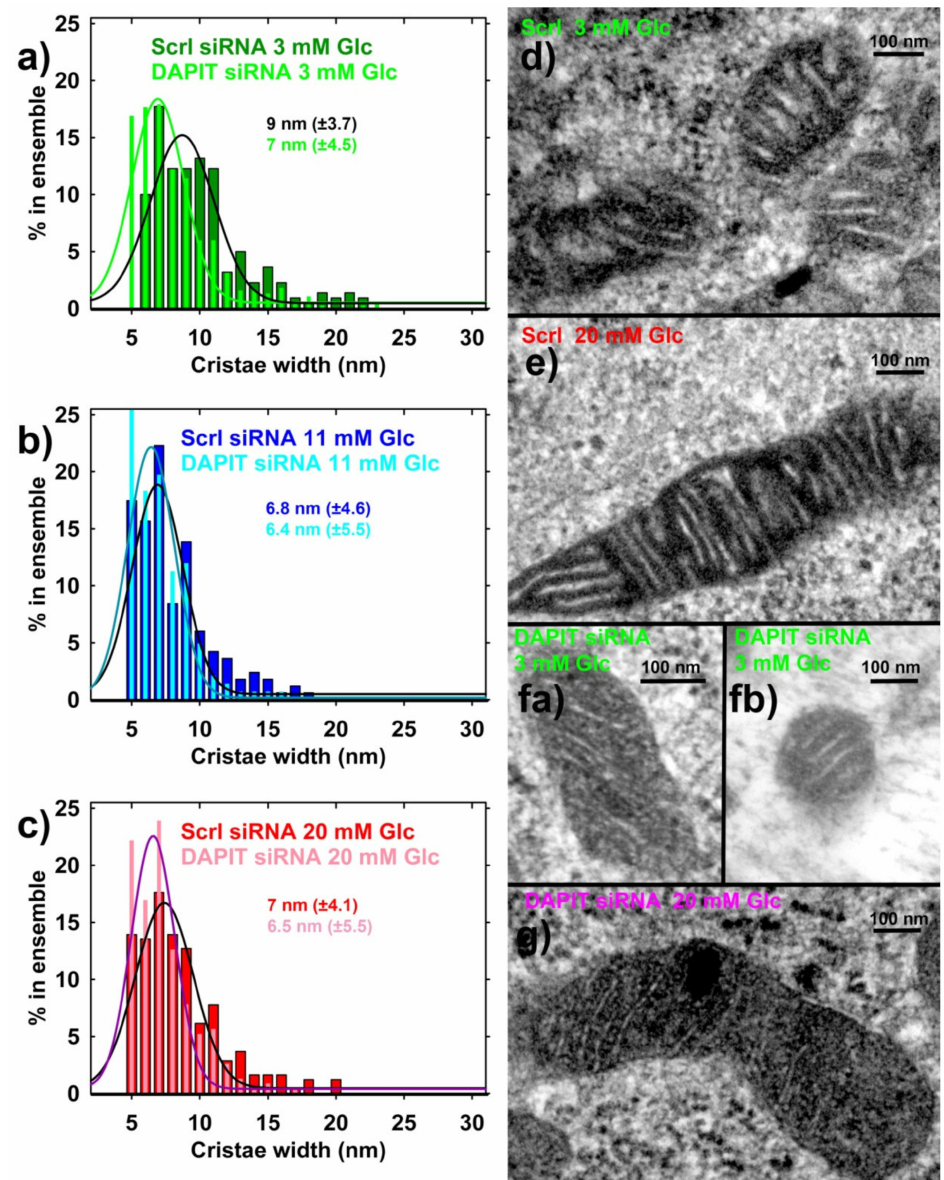
Figure 9. Mitochondrial cristae in DAPIT-deficient INS-1E cells—i.e., silenced for DAPIT, when compared to INS-1E cells transfected with scrambled siRNA ( N = 2). ( a – c ) SDS–polyacrylamide of cristae width; ( d – g ) exemplar TEM images of sections of mitochondrial tubules (i.e., “mitochondria”). Independent incubations with the designated glucose concentrations were performed twice, while n = 275 crista width estimations were made from 15 TEM images for each condition ( n = 450 for DAPIT siRNA at 3-mM glucose). Values of most frequent crista width are listed with SDs taken as 0.5 of half-width, as derived from Gaussian fits of the data (displayed on